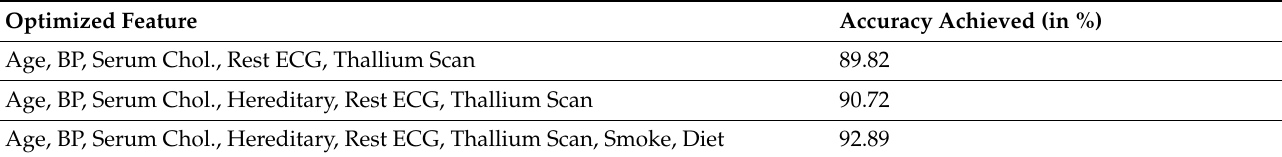
Table 6. Optimized features with M-ABC